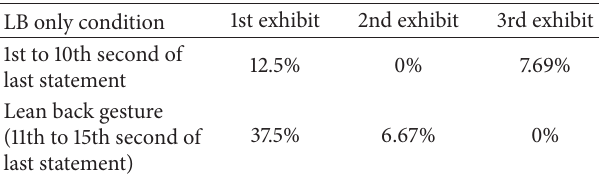
Table 2: Disengagement of the subjects from the exhibits in the SA only condition.